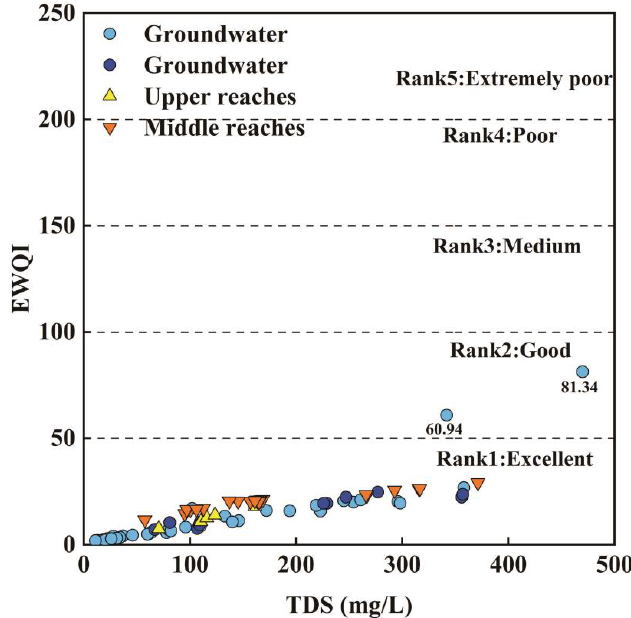
Figure 15. Relationship between surface water and groundwater EWQI and